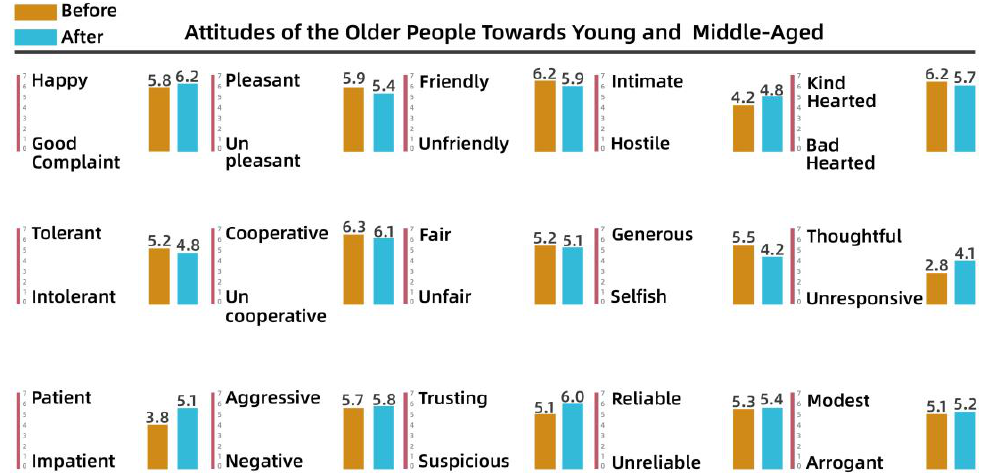
Figure 13. Older people’s attitudes toward young and middle-aged